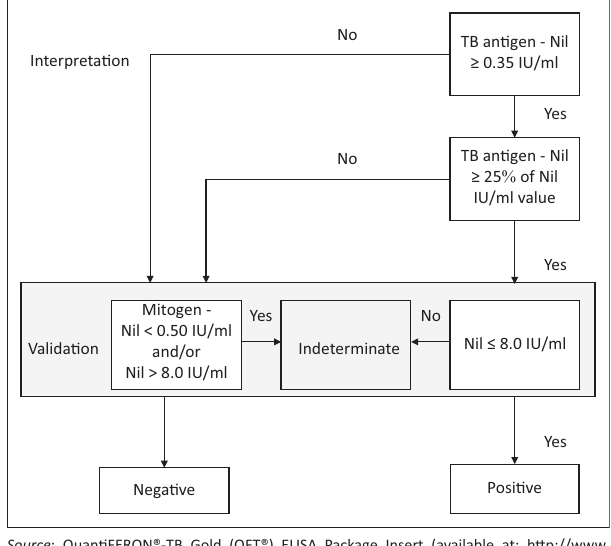
FIGURE 1: Interpretation of interferon-gamma release assays